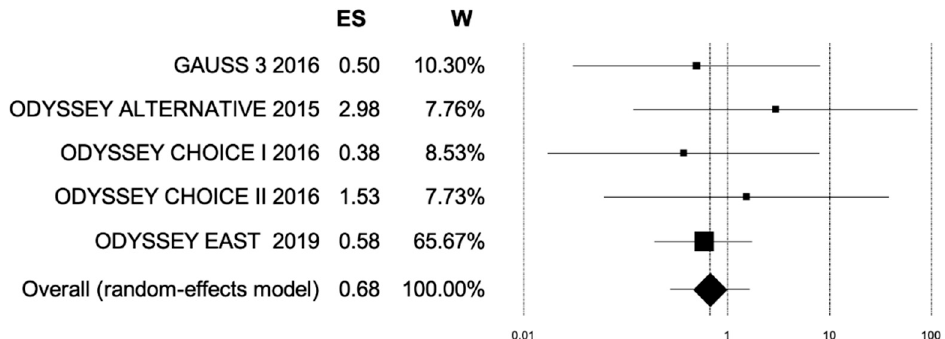
Figure 9. Forest plot for metanalysis of incidence of myocardial infarction. Forest plot depicting effect size and weight for each of the studies included in the meta-analysis of myocardial infarction incidence in anti-PCSK9 group vs. placebo group. Graphically, the effect size is represented as the center of each box while the box size represents the weight of each study and the whiskers represent the 95% confidence interval for each study. Center line (ES = 1) is the line of no effect where inter- vention (PCSK9 inhibitors or placebo) has no effect on outcome (no incidence of myocardial infarc- tion). The overall ES of 0.68 favors PCSK9 inhibitors. ES, effect size; W, weight.